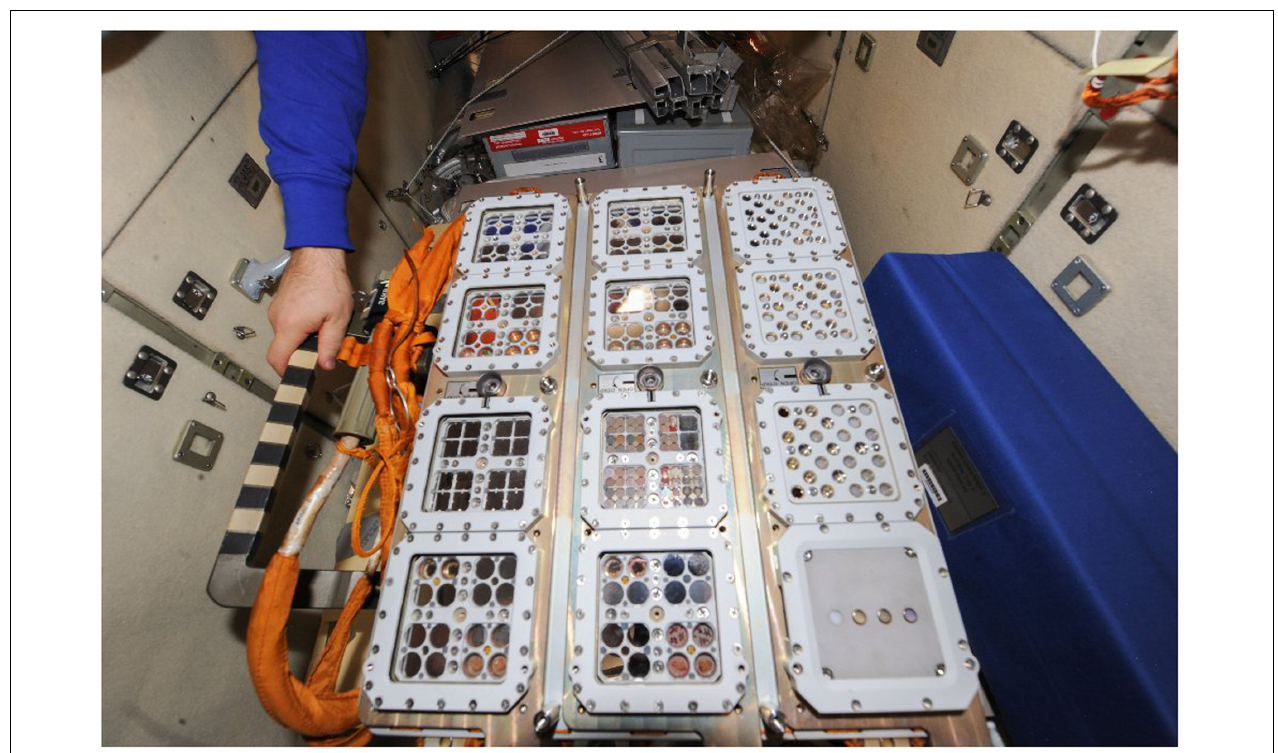
FIGURE 7 | The EXPOSE-R2 trays integrated into the EXPOSE-R monoblock inside the ISS. Credit ESA,